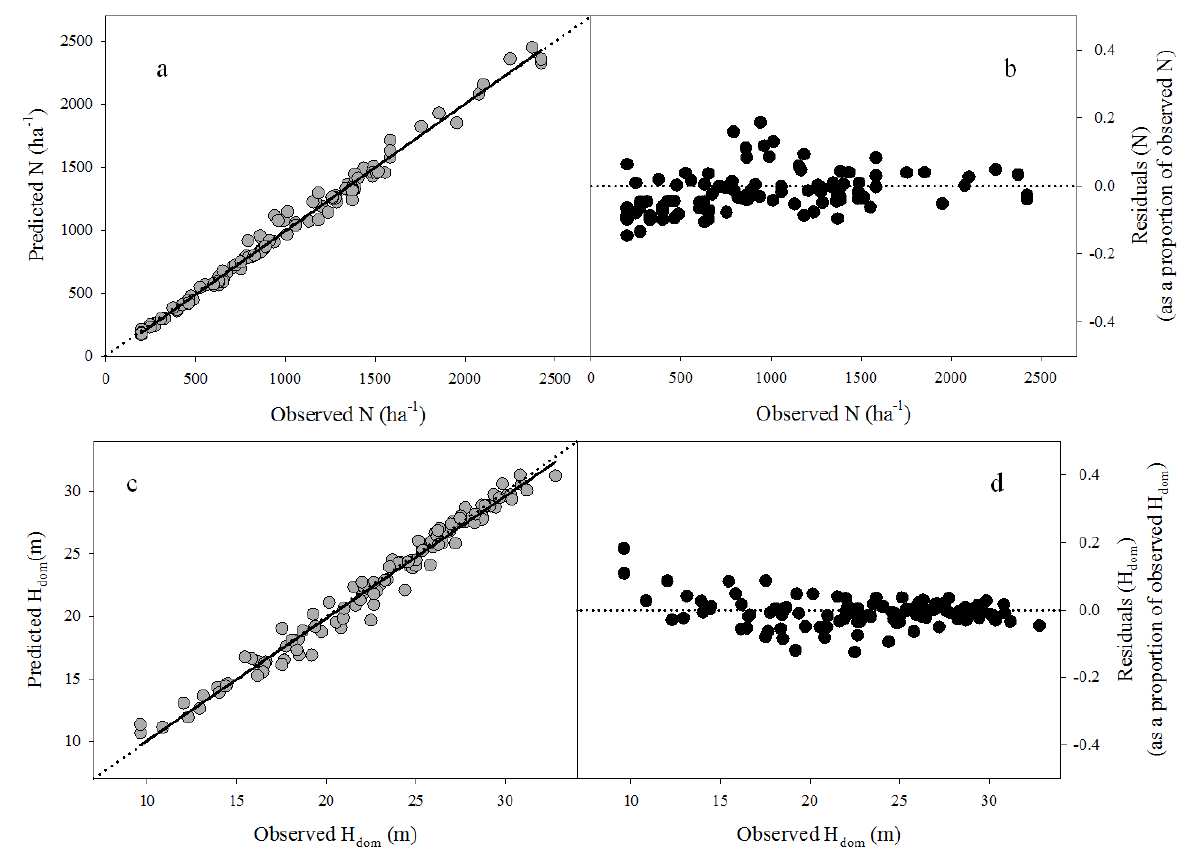
Figure 2. Validation of dominant height (Hdom) ( a , b ), surviving trees per hectare (N) ( c , d ) and basal area for unthinned stands (BA) ( e to h ) models based on 30 plots from the dataset used for model evaluation. Observed versus predicted (simulated) values ( a , c , e and g ) and residuals (predicted-observed) versus stand age (yrs.) relationship of Hdom ( b ) and N ( d ), and residuals versus observed values of predicting ( f ) and projecting ( h ) BA. Solid line represents linear fit between observed and predicted values and dotted lines for plots ( a , c , e and g ) correspond to the 1-to-1 relationship. Residuals are presented as a proportion of observed